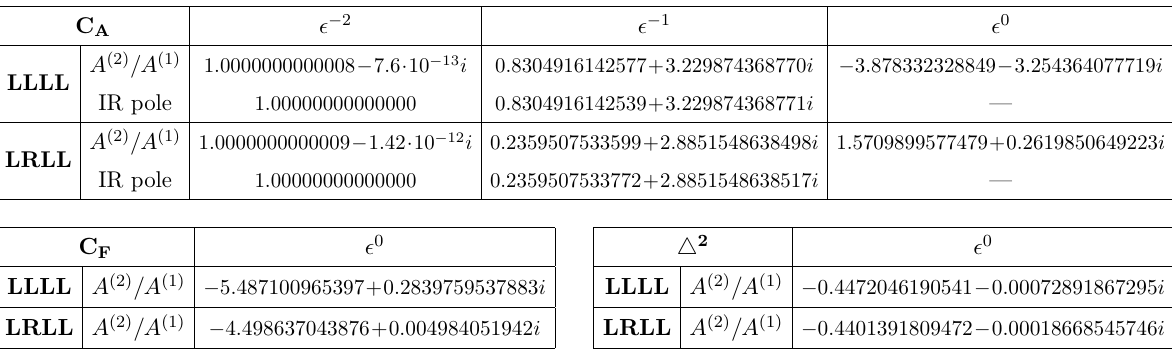
Evaluation of the renormalised two-loop helicity amplitudes, see eq. (2.10), for the phase space point defined in eq. (4.4). We normalise by the one-loop amplitude A (1) | (cid:15) =0 and show the infrared pole structure for comparison, see eq. (2.14). The renormalisation scale is set to µ = m Z = 91